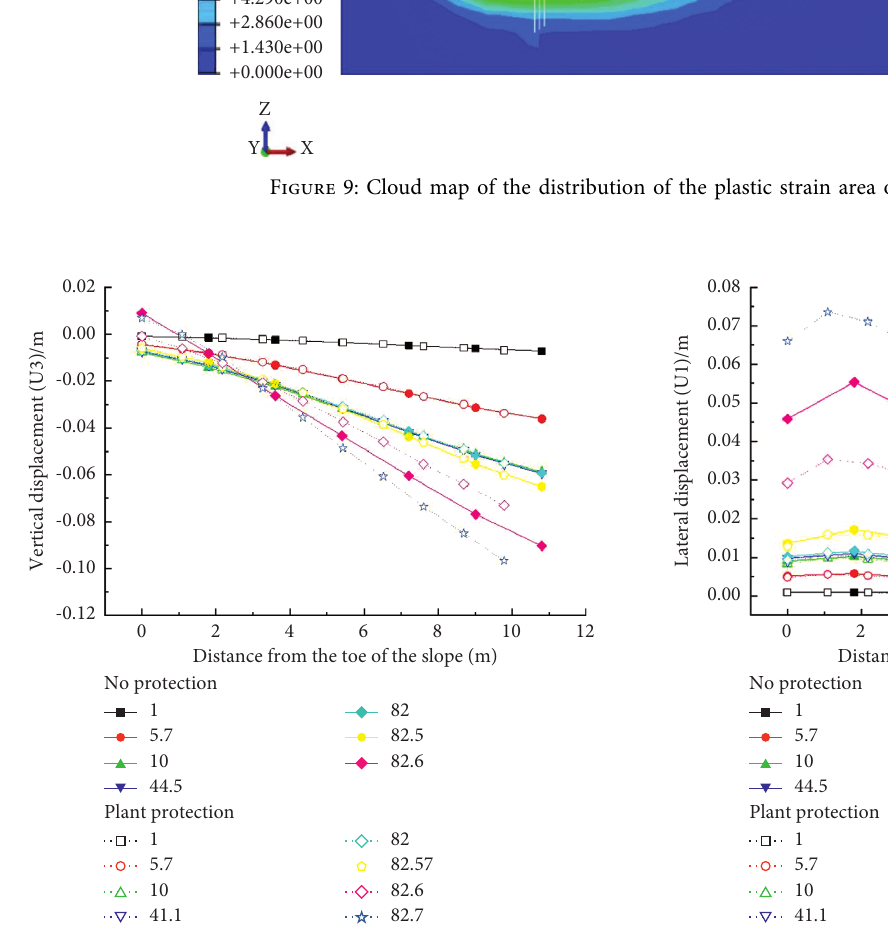
Figure 11: Lateral displacement of each characteristic point of the downslope foot at each